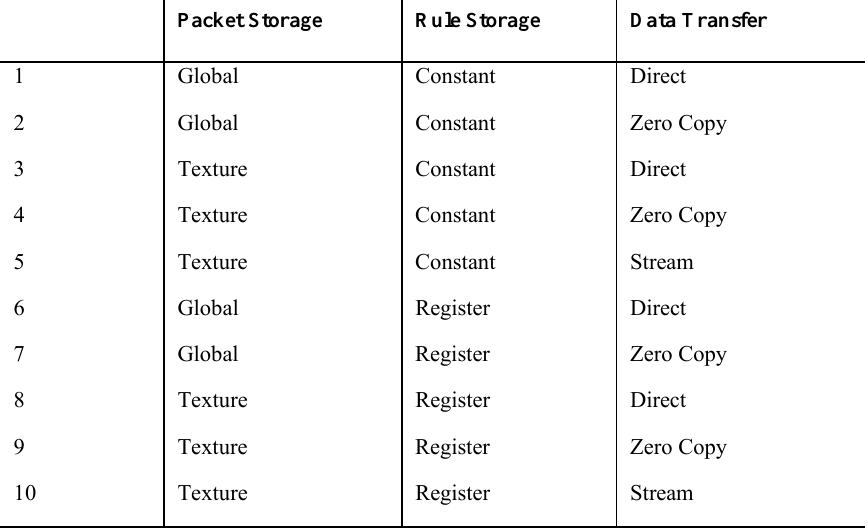
Table 3. Combination of various memory architectures for GPU-based